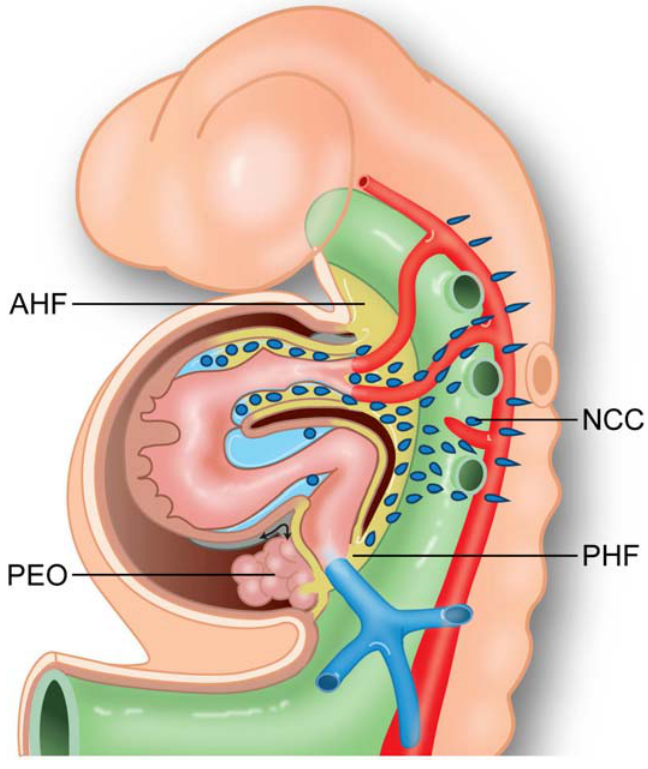
FIGURE 1. Schematic picture of the continuum of the primary (brown and blue) and secondary (yellow) heart-forming fields. The secondary heart- forming field can be divided into the anterior heart field (AHF), at the outflow region of the heart, and the posterior heart field (PHF), at the inlet region of the heart. The PEO, the cauliflower-like protrusion of the sinus venosus into the pericardial cavity, develops as a part of the posterior heart field and can thus be regarded as originating from a cardiac source. The neural crest cells (NCC) are true extracardiac contributors to heart development as they migrate from the neural crest along the arterial and venous pole into the heart, to the blue regions originating from the primary heart field. Adapted with permission from Poelmann and Gittenberger-de